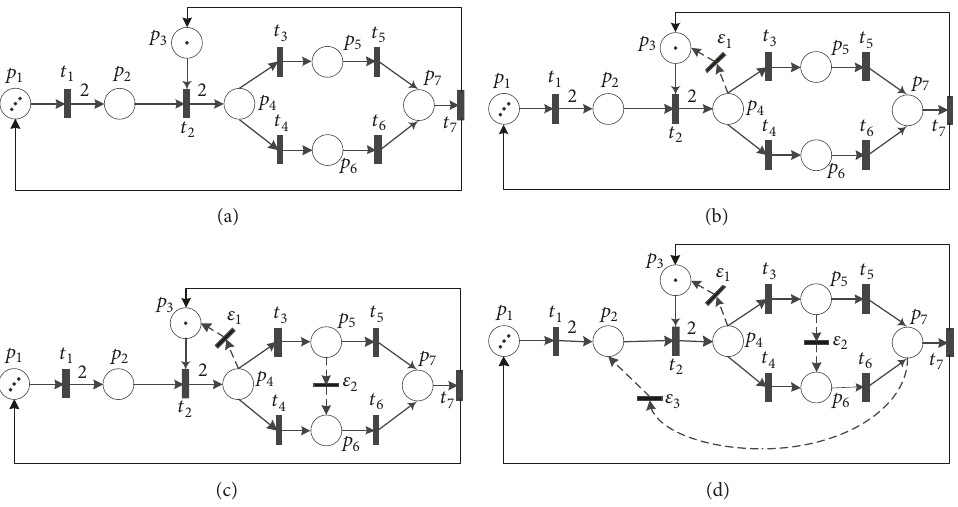
Figure 4: (a) The observable subnet 𝑃𝑁 𝑜 , (b) the net identified after sequence 𝑡 1 𝑡 2 𝑡 2 , (c) the net identified after sequence 𝑡 1 𝑡 2 𝑡 2 𝑡 3 𝑡 6 , and (d) the net identified after sequence 𝑡 1 𝑡 2 𝑡 2 𝑡 3 𝑡 6 𝑡 3 𝑡 6 𝑡 2 by applying Algorithm